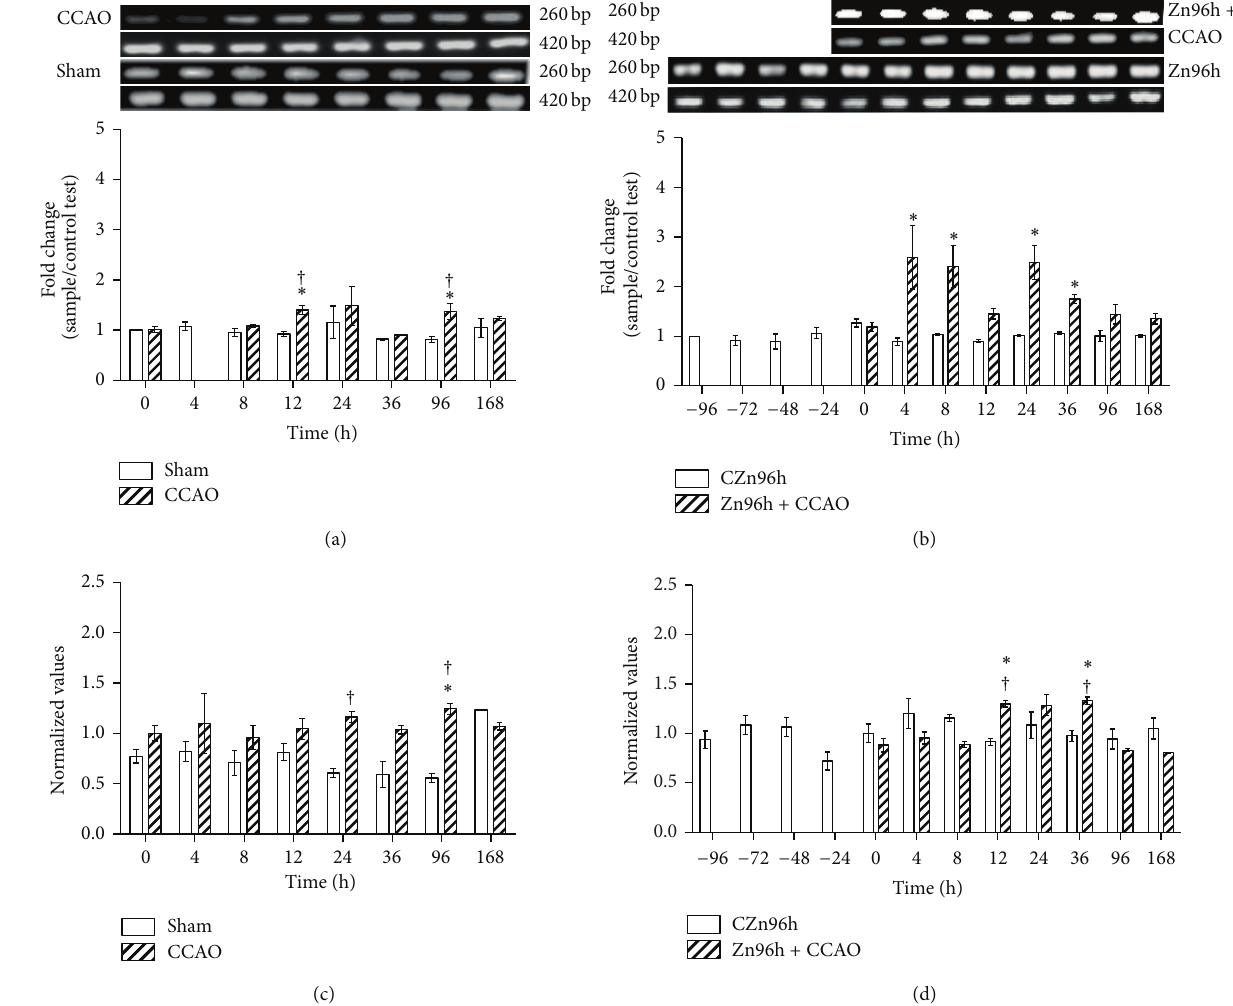
Figure 5: The subacute administration effect of zinc on FGF2 expression levels after hypoxia-ischemia in the rat. RT-PCR was used to determine mRNA levels of FGF2 (260 bp) and GA3PDH (420bp). ((a) and (b)) Showing representative photographs of ethidium-bromide- stained RT-PCR products fractionated on 2% agarose gel and the respective densitometry analysis. ((c) and (d)) Showing the FGF2 protein levels measured using ELISA. Each value represents the mean ± SEM of 5 independent experiments made in triplicate. (1) Zn96h, rats injected with ZnCl 2 (one dose every 24 h during 4 days). (2) Zn96h + CCAO, rats treated with zinc before 10min common carotid artery occlusion (CCAO). (3) CCAO, rats with CCAO only. (4) Sham group, rats with mock CCAO. (5) Untreated rats. ∗ , significant when compared with the control group; ANOVA test and post hoc Dunnett’s test. † , significant when compared between groups; unpaired Student’s 𝑡 -test. 𝑃 < 0.05